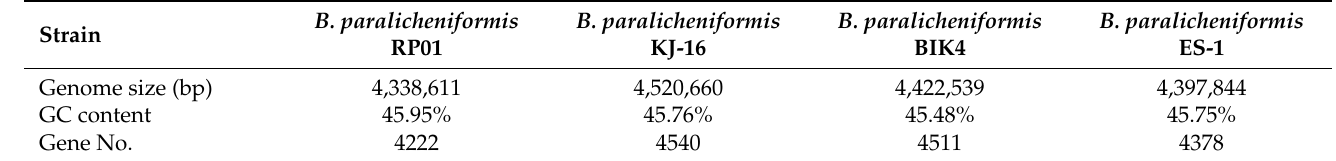
Table 1. General information on Bacillus paralicheniformis RP01 and other three B. paralicheni- formis